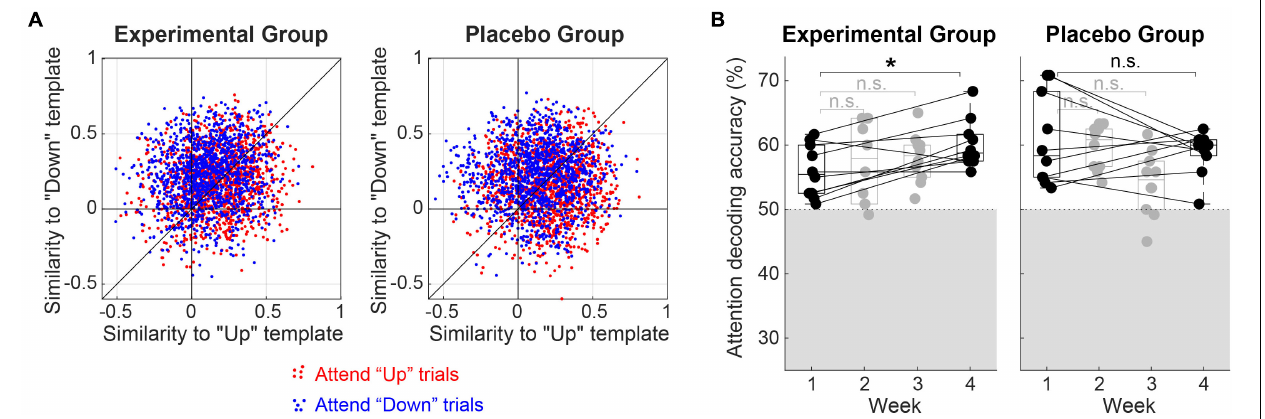
FIGURE 3 | (A) Distributions of correlation coefficients (“Similarity”) between single-trial EEG waveforms and grand-average evoked responses to the single “Up” and “Down” streams (i.e., referred to as “Up” and “Down” templates). Red and blue dots represent trials from “Attend-Up” and “Attend-Down” conditions, respectively. The mean accuracy of attention decoding (i.e., calculated as the averaged ratio of blue dots above the diagonal and red dots below the diagonal) was 59.1% for the Experimental Group and 58.1% for the Placebo Group. (B) Changes in attentional modulation during training. Attention decoding accuracies from individual subjects are denoted as filled circles over 4 weeks of training. The gray shade indicates an area below the chance level (i.e., 50%). A box plot in each week shows the 75th percentile, median, and 25th percentile line. *Significant at p < 0.05, n.s.: not